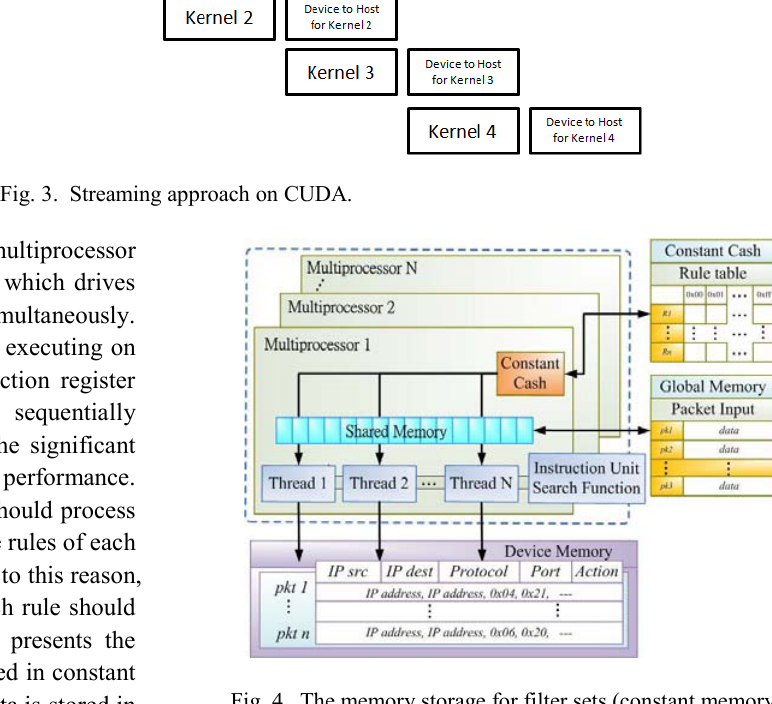
Fig. 4. The memory storage for filter sets (constant memory) and packet data (global memory) on CUDA device.